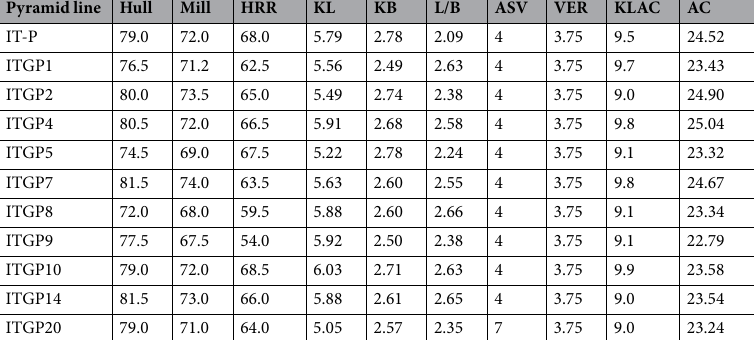
Table 4. Grain quality traits of the selected gene pyramids. Hull-Hulling (%); Mill-milling (%); HRR-Head rice recovery (%); KL-kernel length (mm; KB-kernel breadth (mm), L/B-length breadth ratio; ASV-alkali spreading